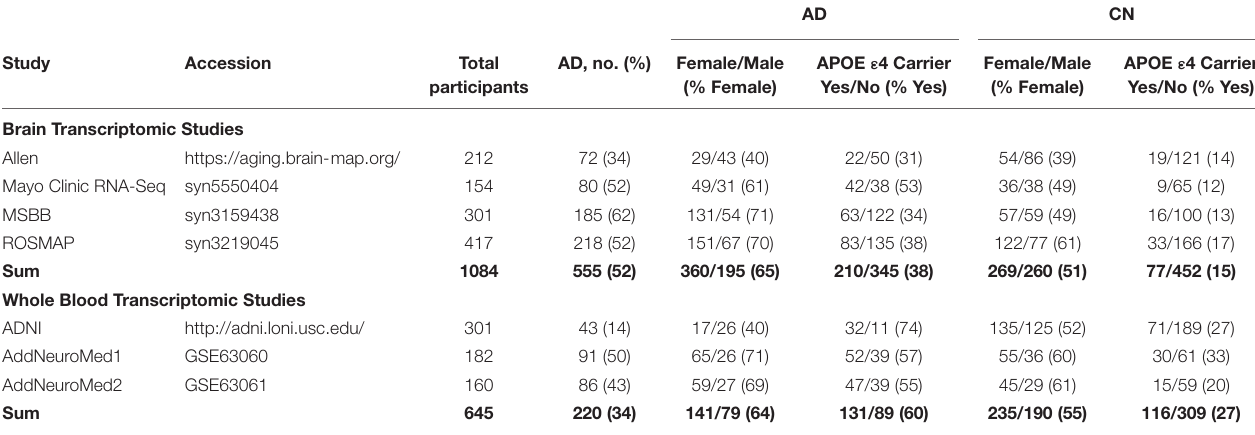
TABLE 1 | Meta-analysis study